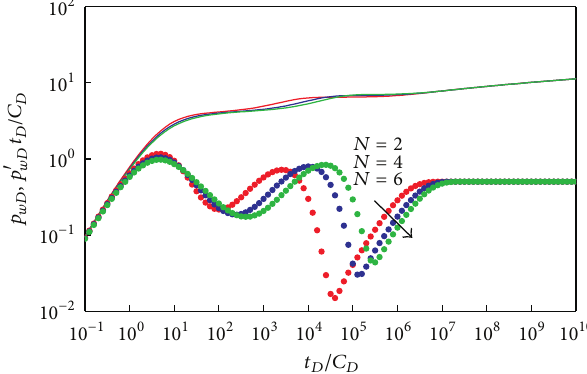
Figure 4: Effect of initial branch number ( N ) on type curves ( 𝛼 = 1 , 𝛽 = 0.707 , 𝜃 = 1 , 𝑀 = 10 , 𝑙 = 0.1 m, 𝑆 = −1 , 𝐶 𝑟 𝑤 and 𝐶 𝑓𝑡 = 1 × 10 −4 MPa −1